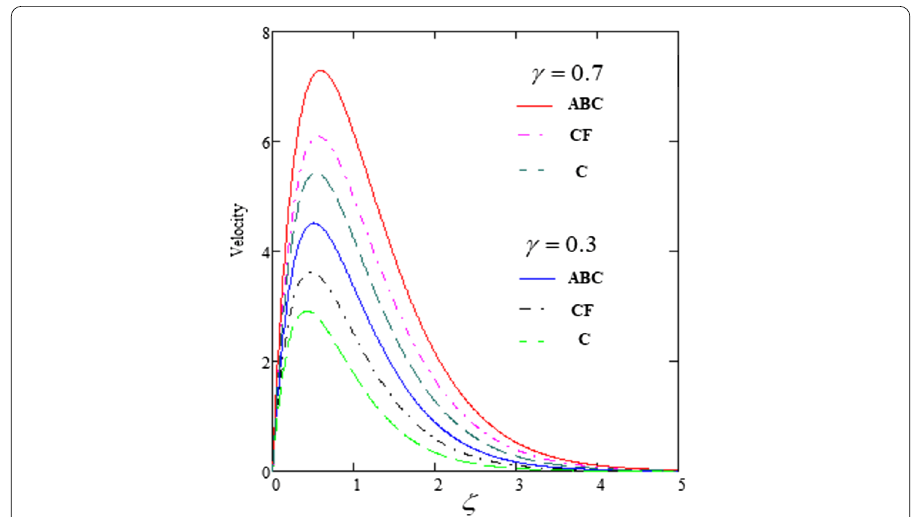
Figure 9 Velocity curves for C, CF and ABC for various values of γ